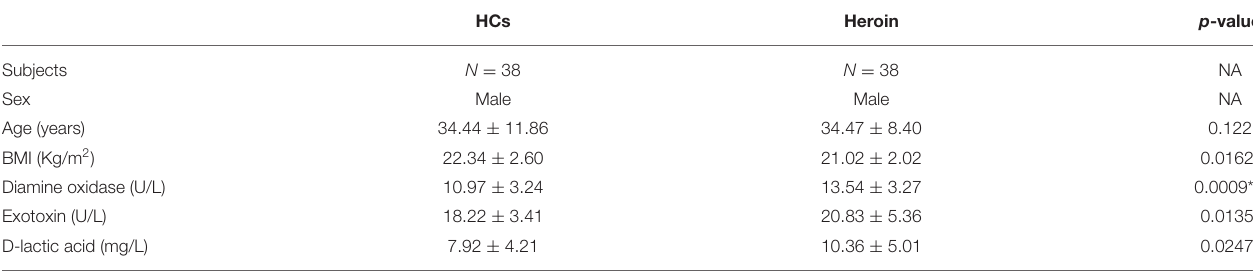
TABLE 1 | The clinical information and intestinal barrier indicators of study population. HCs Heroin p